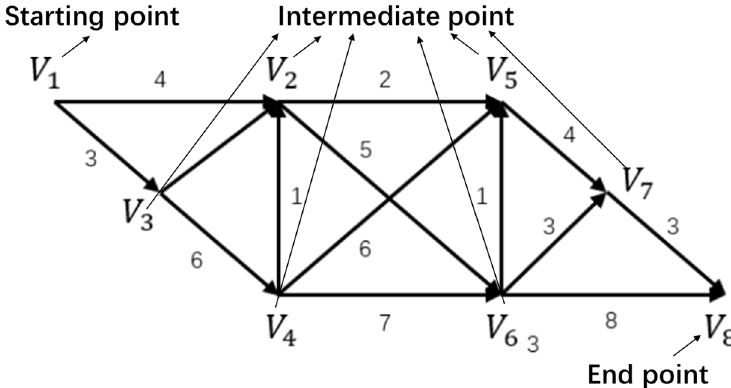
Figure 3. Transportation network diagram including nodes and links .